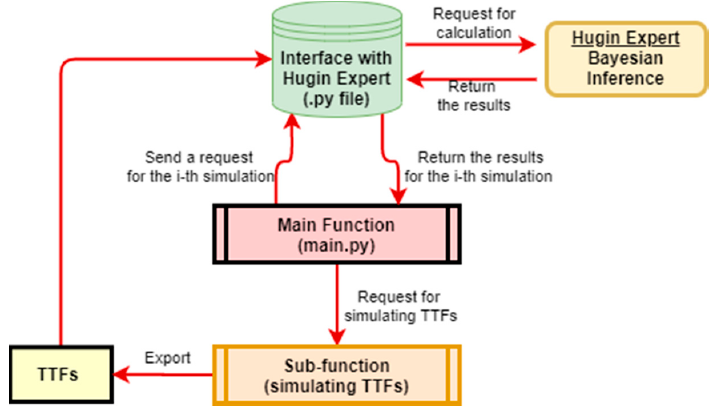
Figure 9. Work flow of the reliability module in the modeling tool.